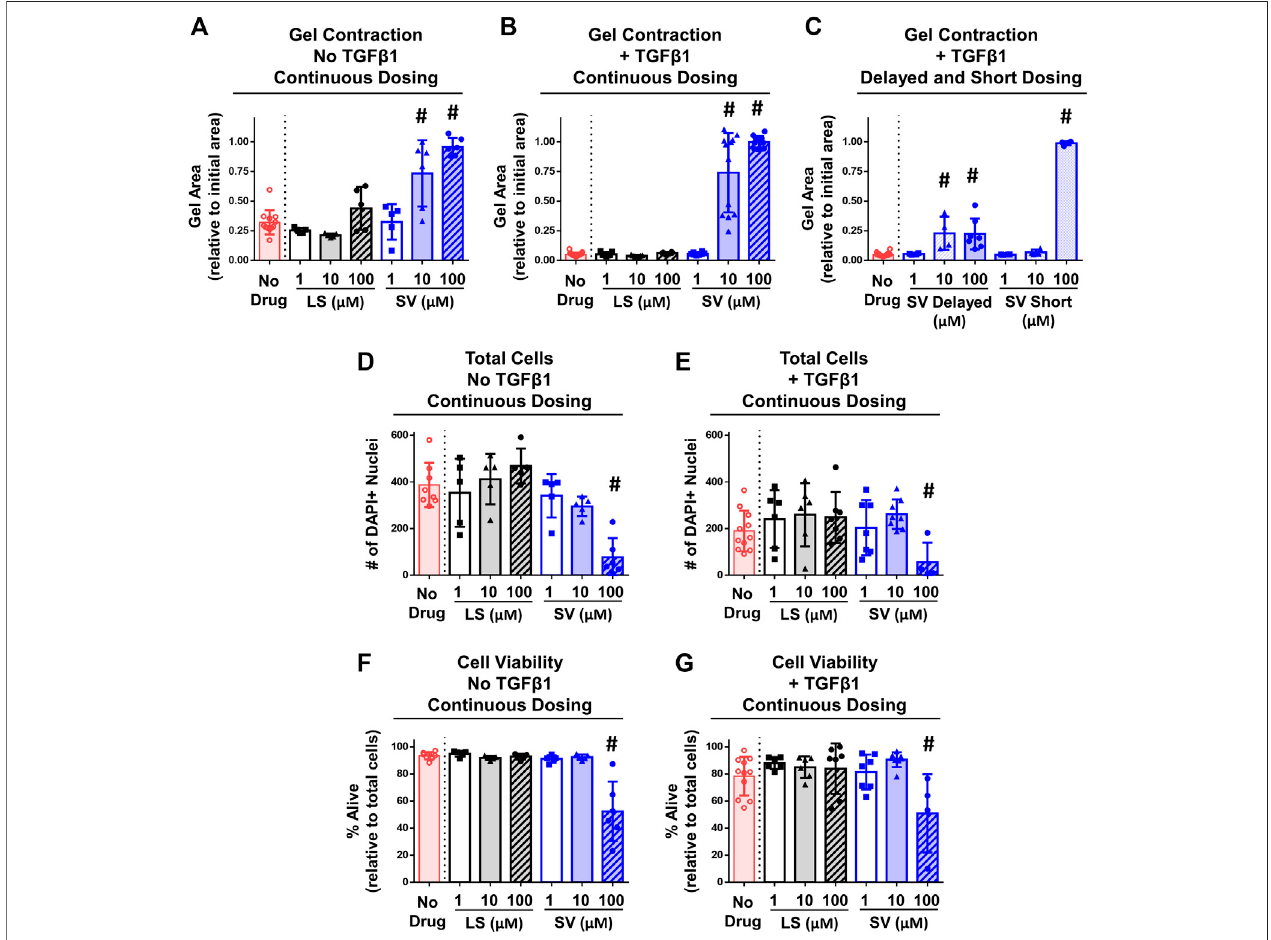
FIGURE 6 | SV, but not LS, reduced fi broblasts/myo fi broblasts contractility and viability in vitro. (A – C) Quantitative assessment of gel contraction area demonstrated that continuous, delayed, and short application of SV, but not LS, reduced contraction without and with TGF β 1 after 6 days. (D – G) Assessment of